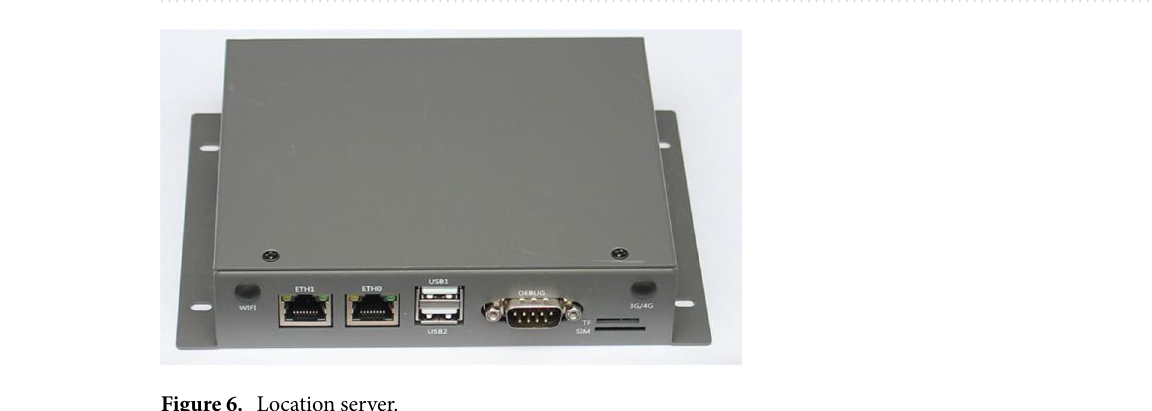
Figure 6. Location server.